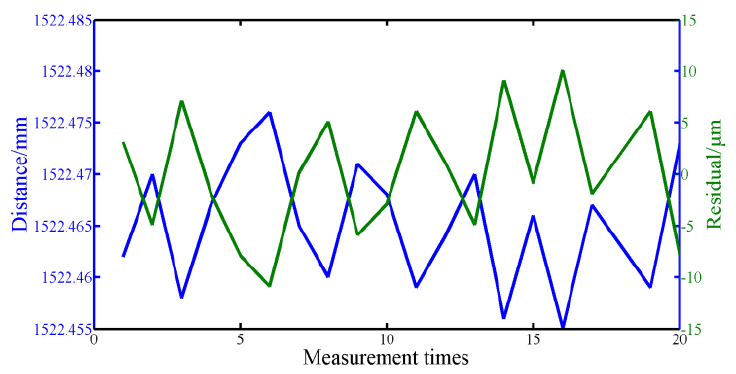
Figure 8. The measurement results of our FSI-based system.